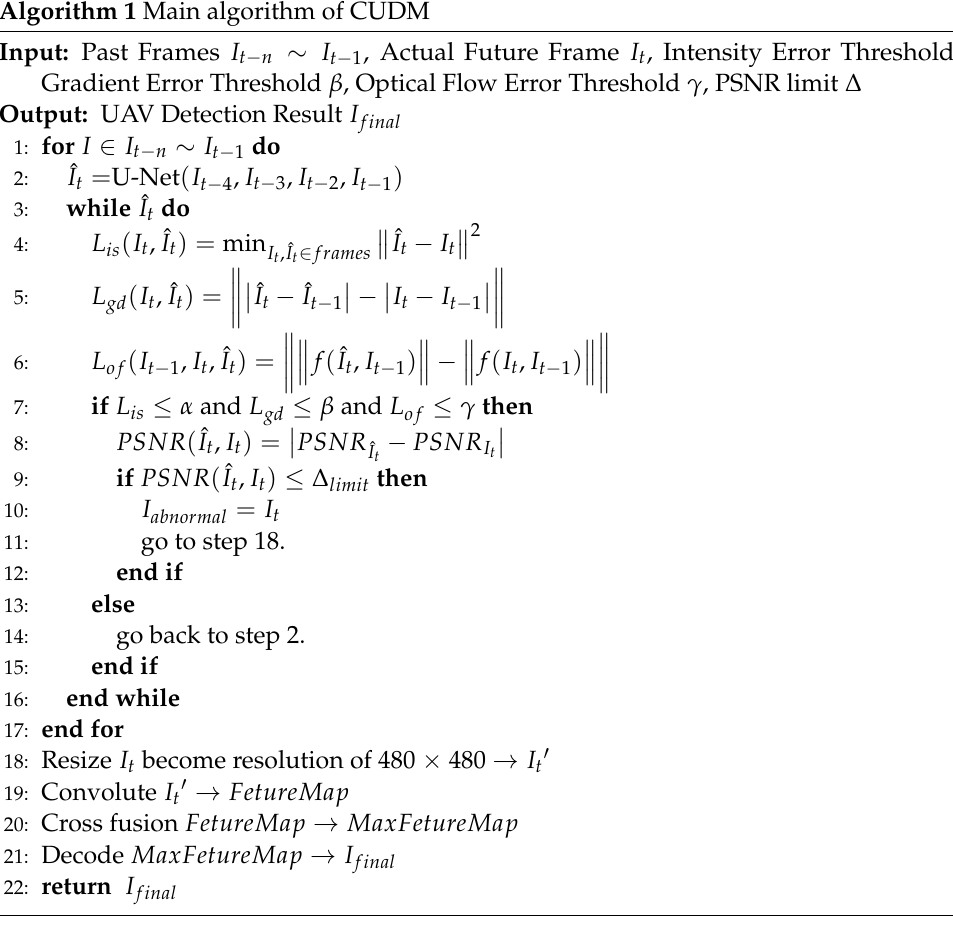
Algorithm 1 Main algorithm of